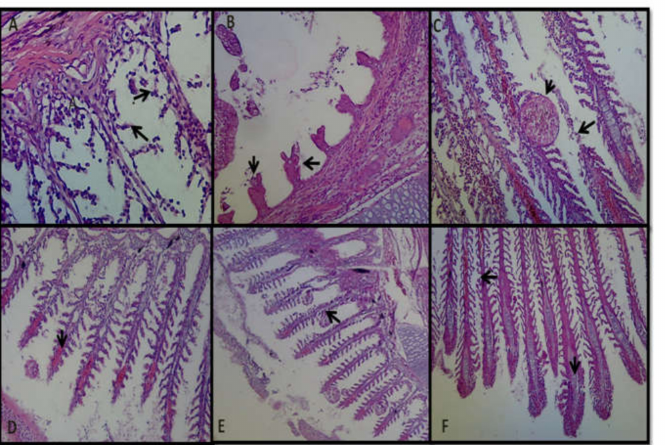
Figure 7. Hematoxylin and eosin staining slide of arsenic-treated fish gill (400 × ). Arrowhead ( → ) sign indicates the change in gill structure due to arsenic treatment. ( A ): Necrosis and damages of secondary gill lamellae (T3). ( B ): Irregular shape and damage of gill rakers (T3). ( C ): Necrosis of primary gill lamellae and fusion and hyperplasia of secondary gill lamellae (T3). ( D ): Vasodilation in primary gill lamellae (T2). ( E ): Edema and epithelial proliferation. ( F ): Lamellar blood congestion and proliferation of vascular space toward the end of primary gill lamellae (T1). Photos were taken using Nikon AF-S DX,